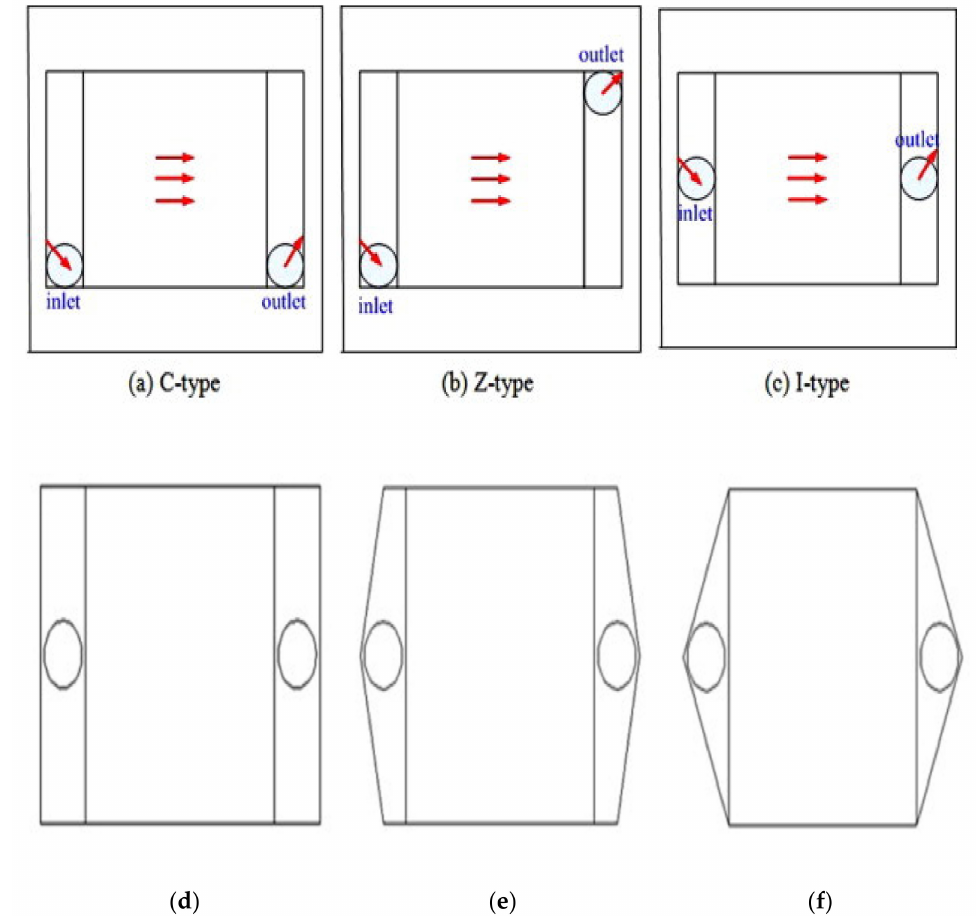
Figure 3. Different inlet and outlet positions and header shapes of micro-channel heat sinks [63] ©